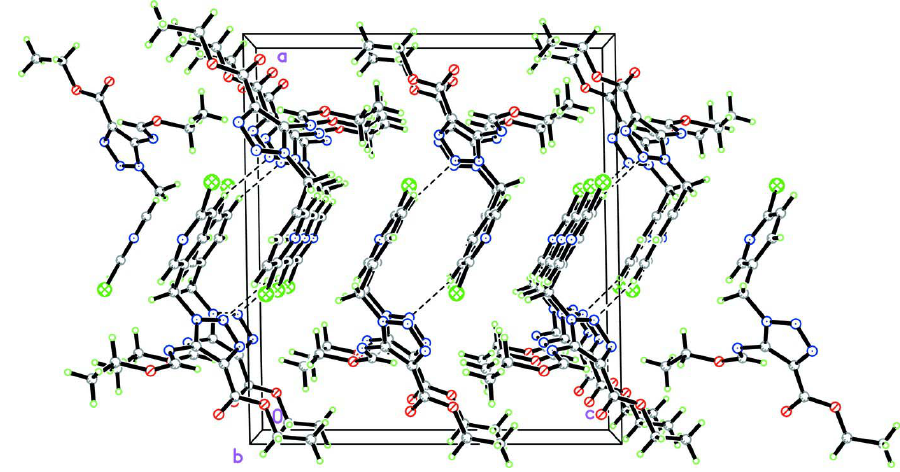
Figure 2 A partial view of the crystal packing of (I), showing the formation of C—H···O and C—H···N hydrogen-bonding interactions (dashed